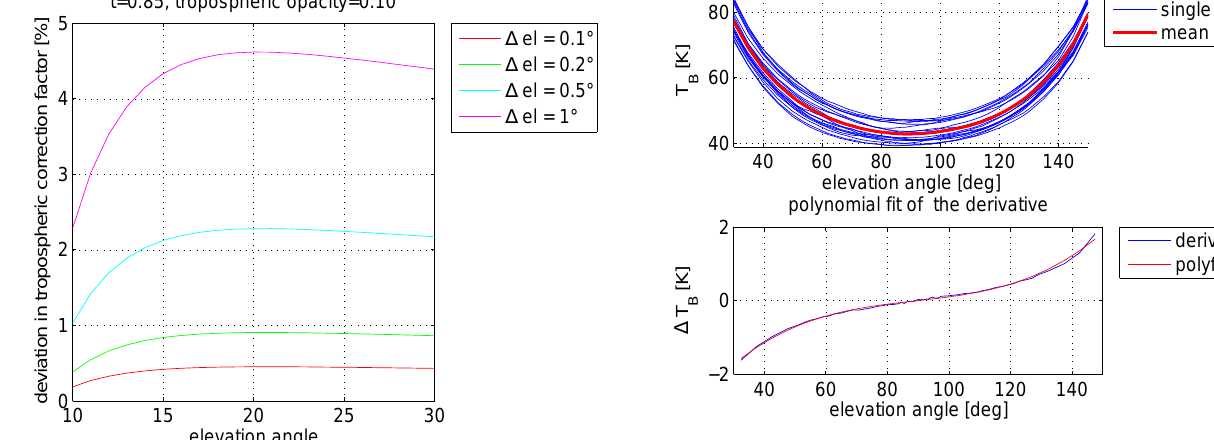
Fig. 8. Influence of a pointing offset in elevation on the tropospheric correction factor according to Eq. ( 15).